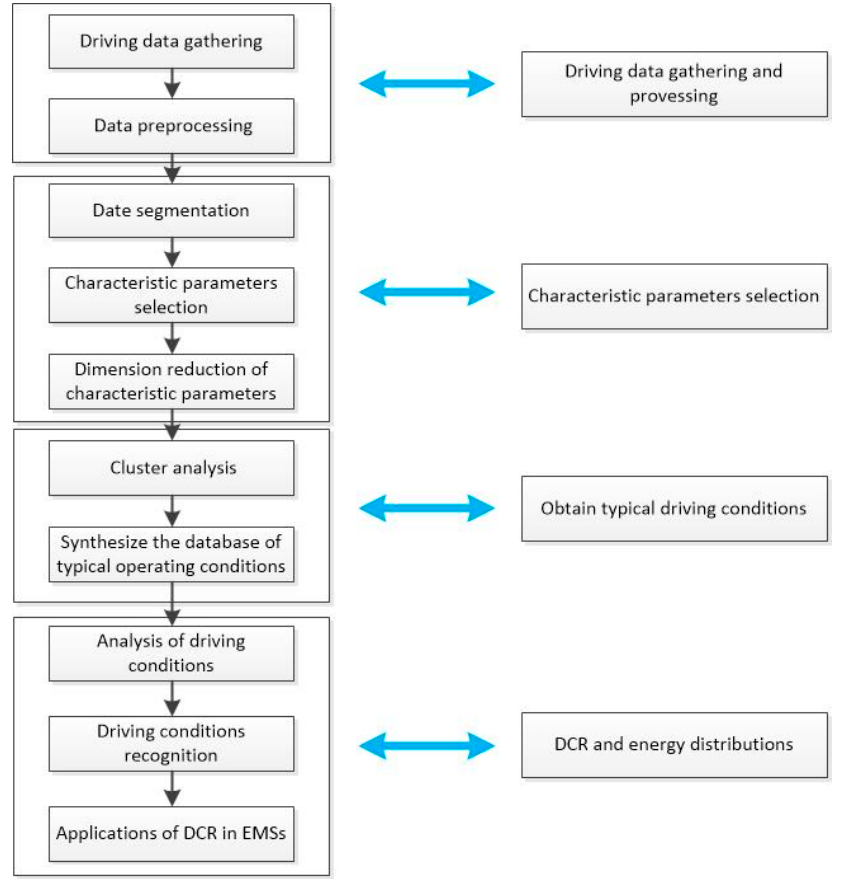
Figure 2. DCR-based EMSs basic problem structure.